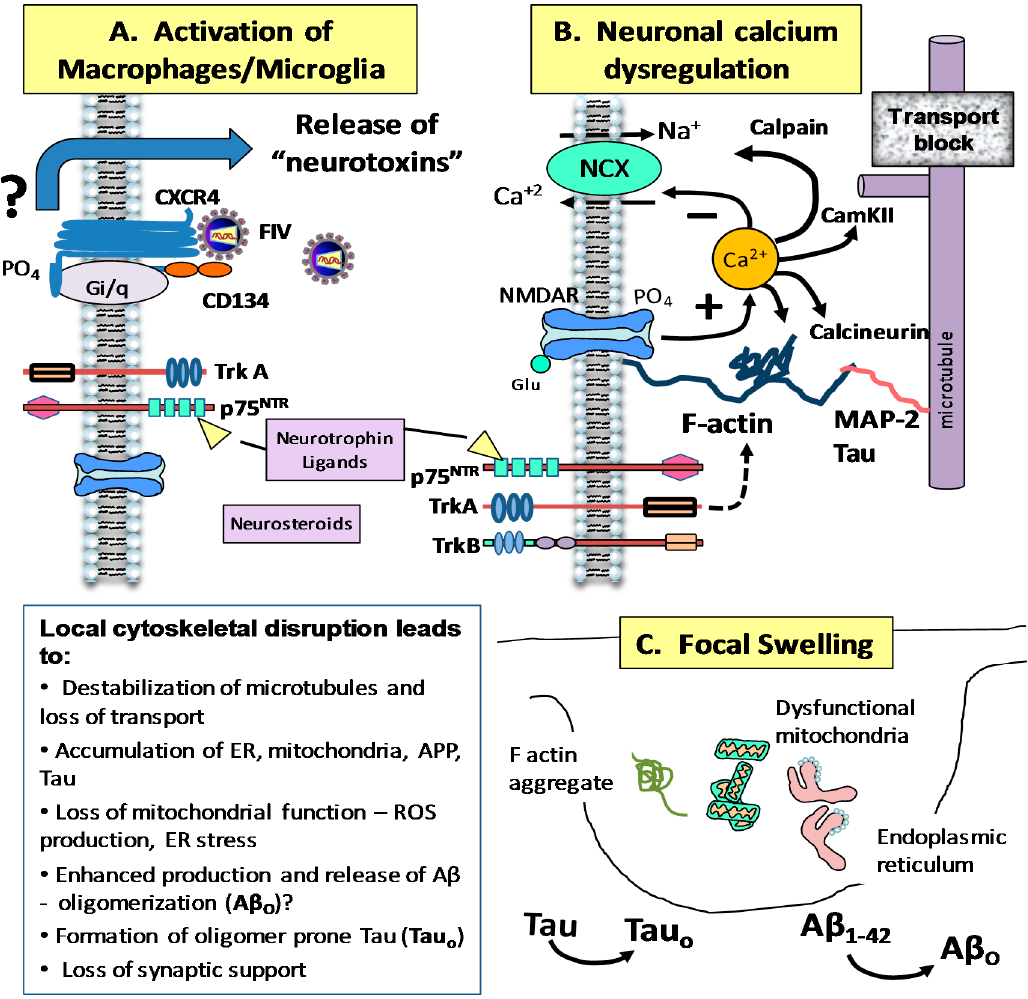
Figure 6. Summary of inflammation-associated neuropathogenesis in response to FIV. ( A ) FIV infects monocytes and macrophages through interactions with CD134 and CXCR4. The virus rapidly gains access to the brain via transmigration of infected monocytes at the blood brain barrier or macrophages at the blood-CSF barrier and establishes what is thought to be a self-sustaining reservoir within microglia. Activation by FIV results in the release of factors that have toxic effects on neurons. The processes that control toxin release are not well understood but appear to be regulated in part by neurotrophins. ( B ) Factors (“Neurotoxins”) in the secretome of the mononuclear phagocytes enhance neuronal calcium signaling in response to glutamate and inhibit the ability of neurons to recover to resting calcium levels. The loss of recovery is thought to be due to a loss of sodium-calcium exchanger (NCX) function. The net result is a gradual, sustained accumulation of calcium that disrupts the cytoskeleton. Activation of calcium-dependent enzymes such as calpain, CamKII, and calcineurin may contribute to actin destabilization and loss of structure. ( C ) The loss of structure disrupts transport and results in focal swelling (beading) of axons and dendrites. The accumulation of mitochondria, endoplasmic reticulum, amyloid precursor protein (APP) and Tau in the swellings may set the stage for oxidative stress and potential cleavage of oligomerization prone Abeta and Tau. The p75 neurotrophin receptor ligand LM11A-31 reduces calcium accumulation and protects the cytoskeleton. Neurosteroids may offer protection by reducing inflammation.